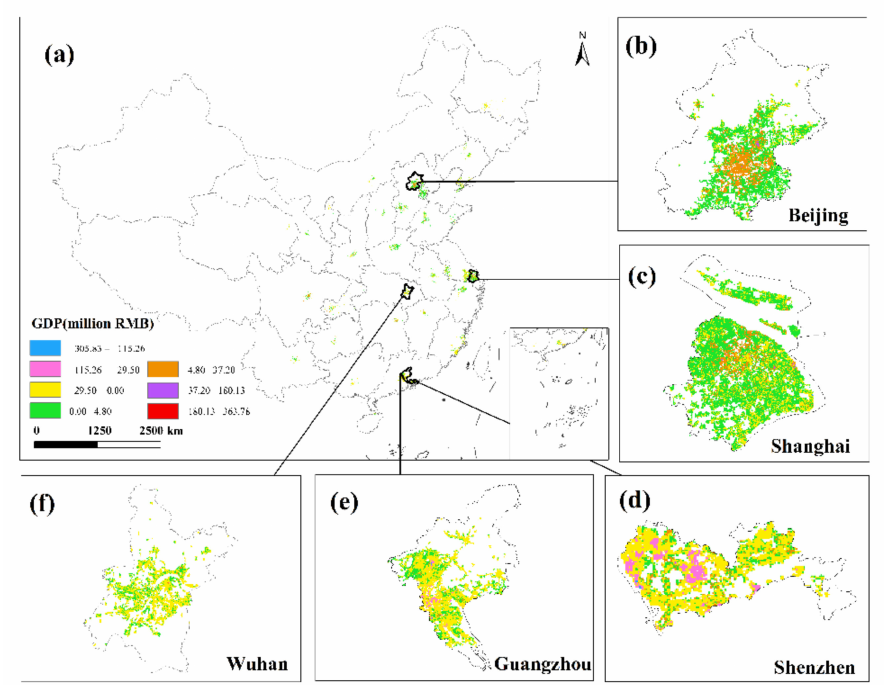
Figure 15. The spatialized result of the sum of GDP in March minus the sum of GDP in February. ( a ) The changes in GDP of 34 cities in China from February to March; ( b ) Beijing; ( c ) Shanghai; ( d ) Shenzhen; ( e ) Guangzhou; ( f ) Wuhan.